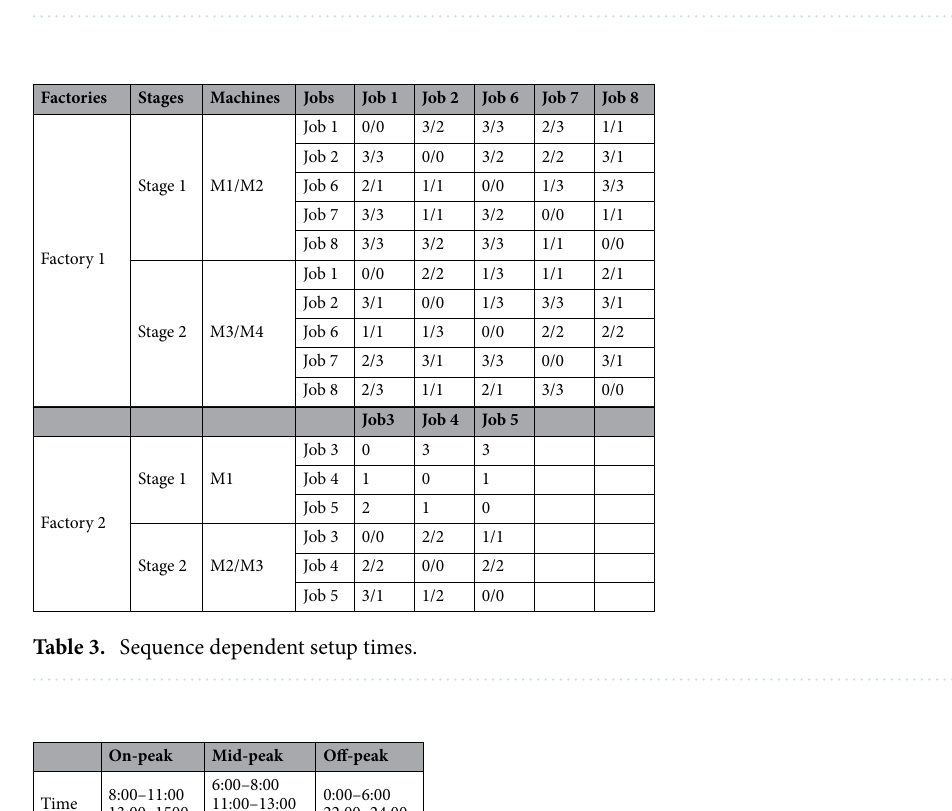
Table 2. Processing times.